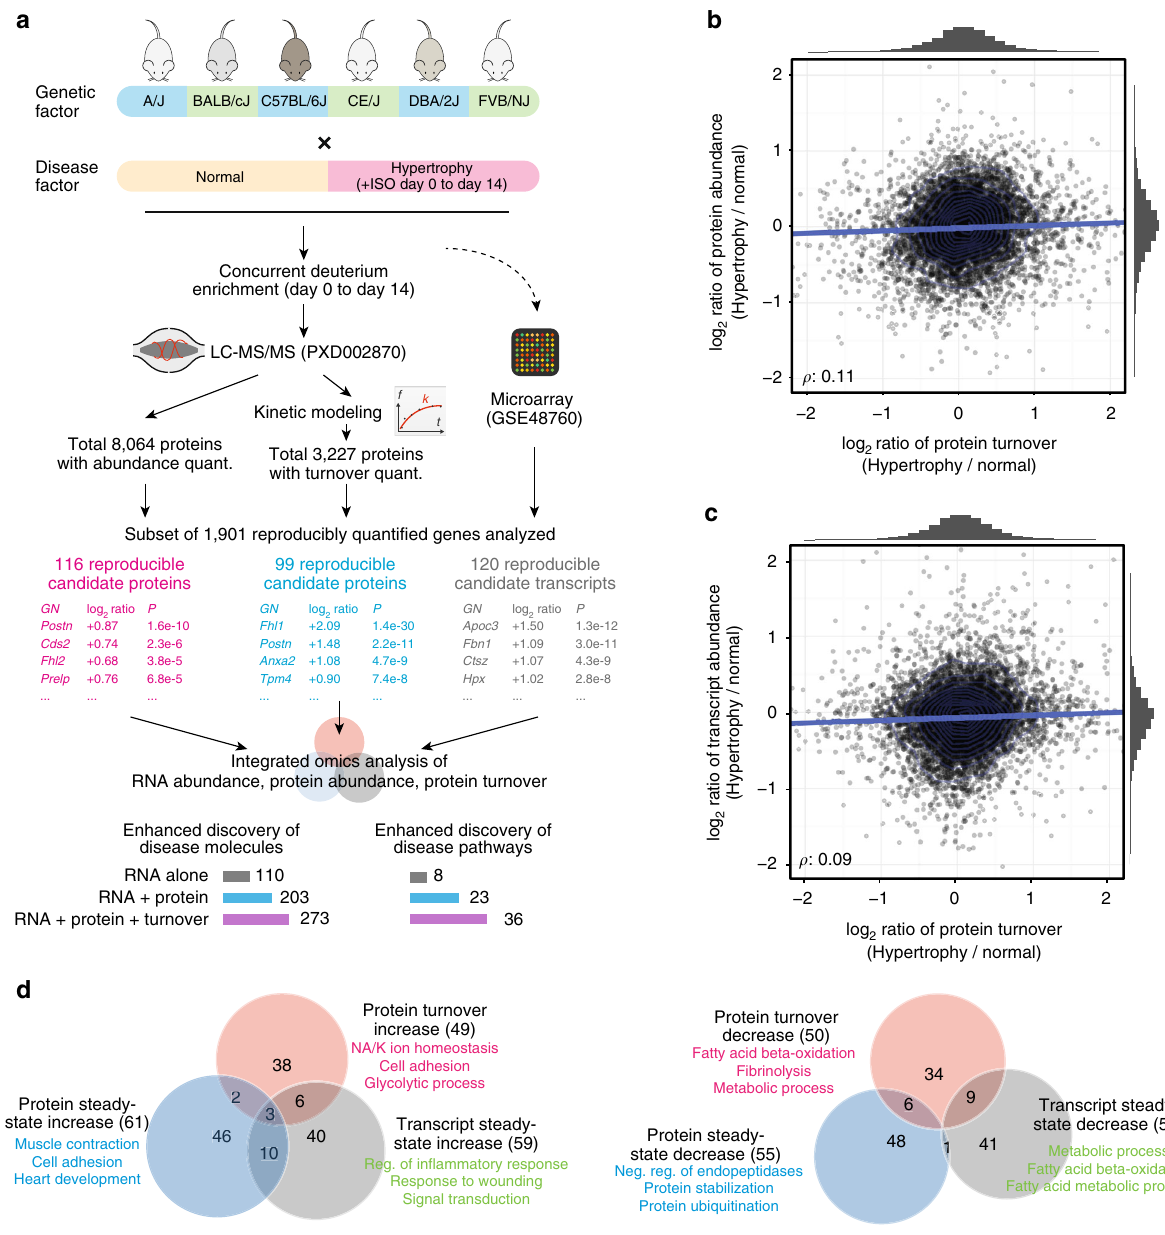
observed low commonality in candidate disease proteins when comparing turnover disease signatures with protein abundance signatures (12%) or transcript abundance signatures (18%) (Fig. 1d). This observation persisted when an alternative method of protein quanti fi cation using tandem mass tag was performed (Supplementary Fig. 3). From the 273 candidate disease signatures, 99 proteins exhibit consistently altered turnover rates;